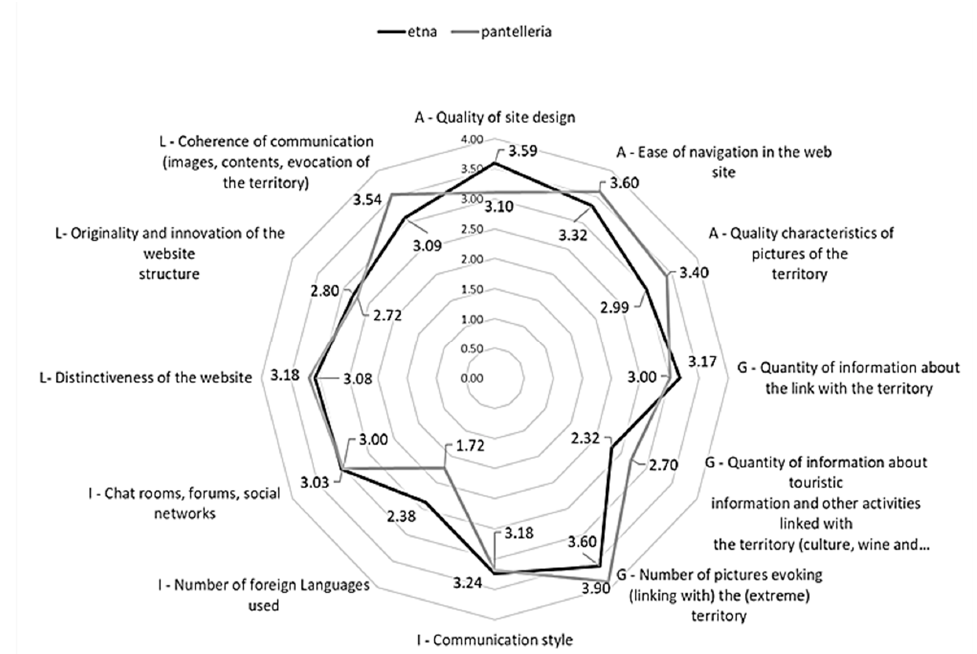
Figure 3. Comparative analysis between scores (mean values) given by focus groups to indicators of the wineries’ websites of the two territories (Etna Mountain and Pantelleria).